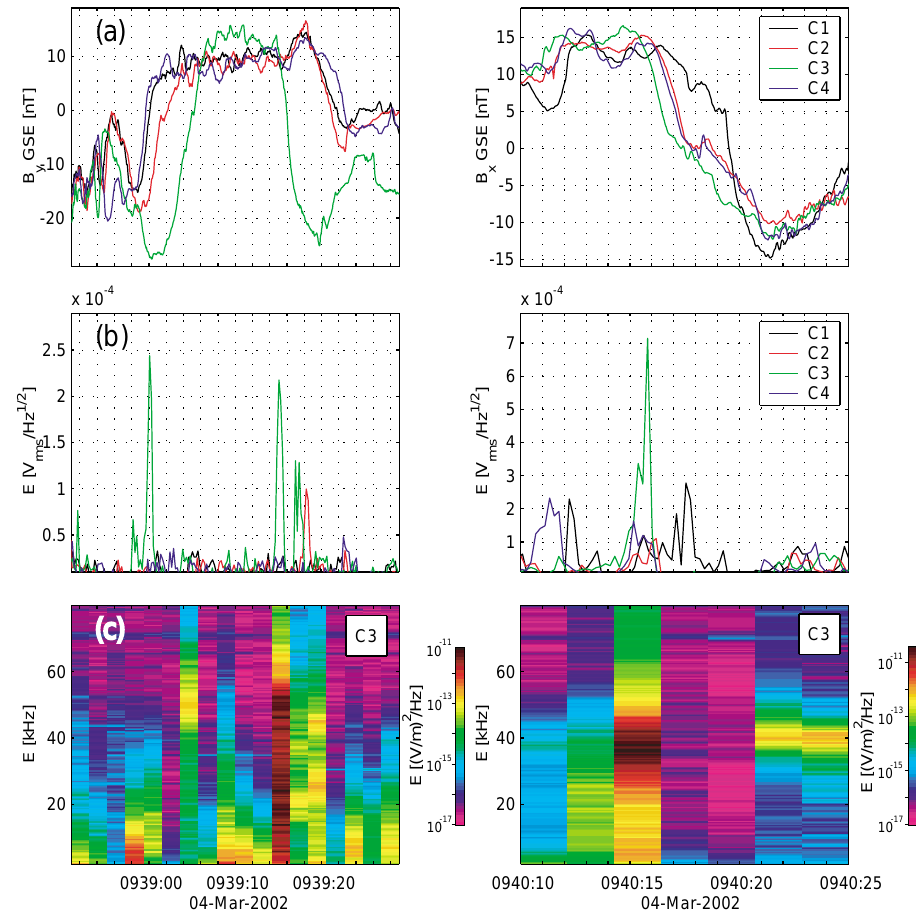
Fig. 4. Two events of enhanced high-frequency waves observed in association with strong localized current sheets. Panels show (a) largest varying component of the magnetic field, (b) integrated spectra of the electric field in a range 2–80kHz observed by all Cluster spacecraft and (c) spectra of the electric field observed by Cluster